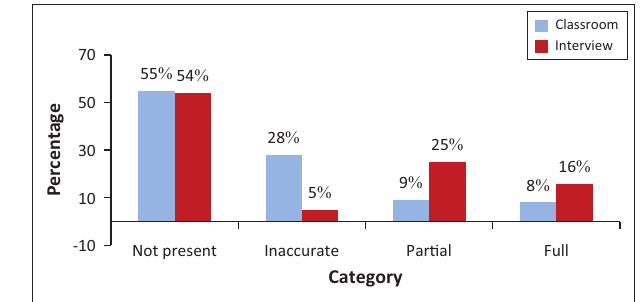
FIGURE 5: Awareness of the error (averages across all rounds).